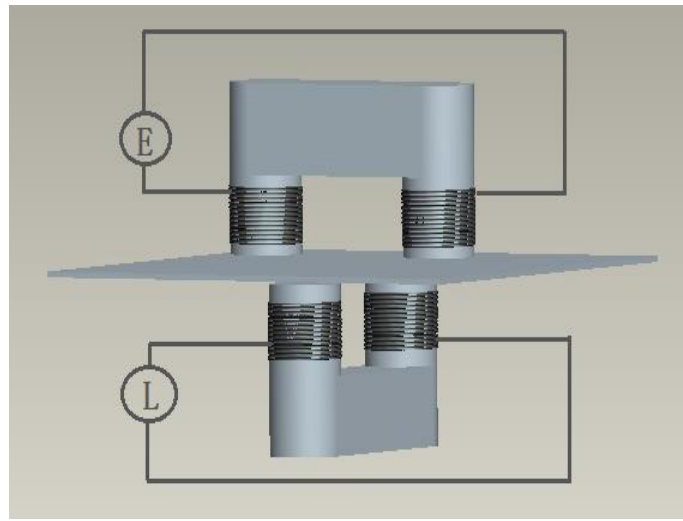
Figure 1. Schematic representation for the transmissive layout of magnetic measurement